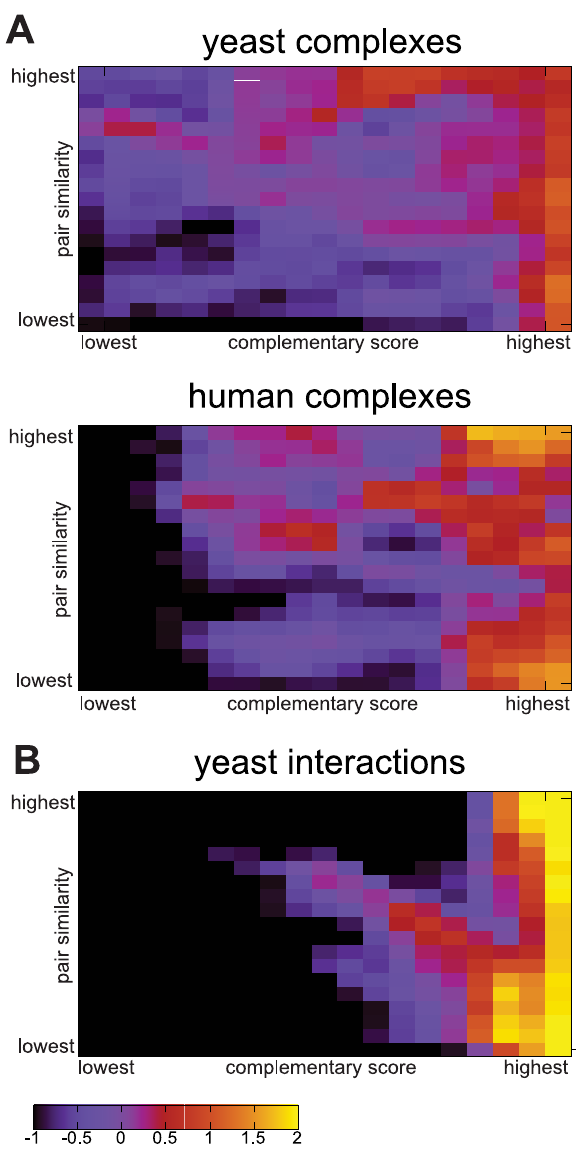
Figure 5. Heat maps showing the enrichment of (A) co-complex pairs or (B) yeast interactions as a function of pairwise profile similarity scores and triplet-based complementarity scores. The color intensity corresponds to the log2-enrichment of protein pairs that are part of the same complex or interact, among all protein pairs inside a pair- and triplet-based